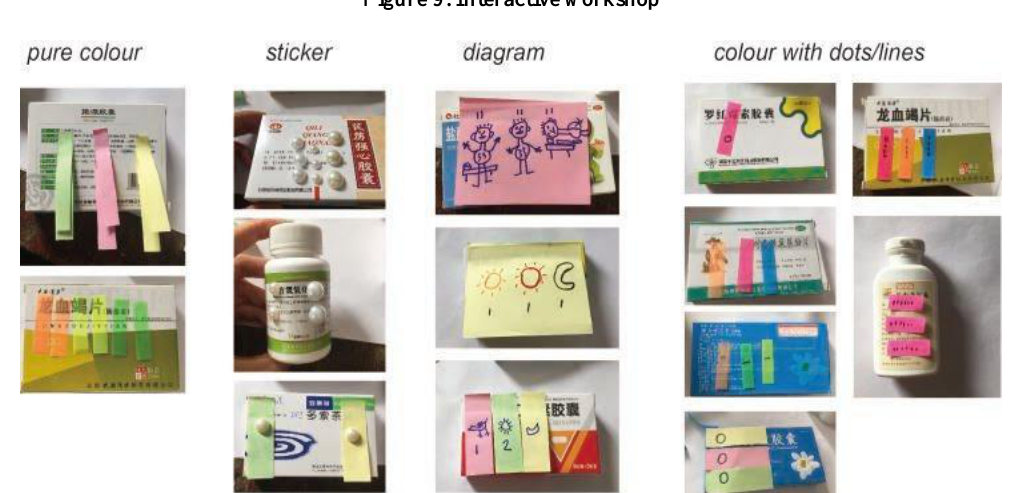
Figure 9. Interactive workshop